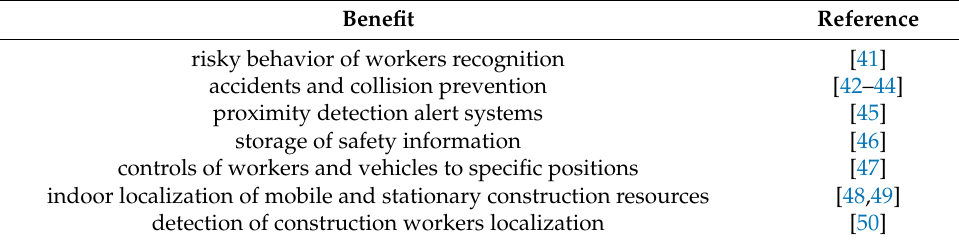
Figure 3. Hazard energy monitoring and safety barrier response in the tunnel shaft area [41]. Table 2. RFID technology in construction safety